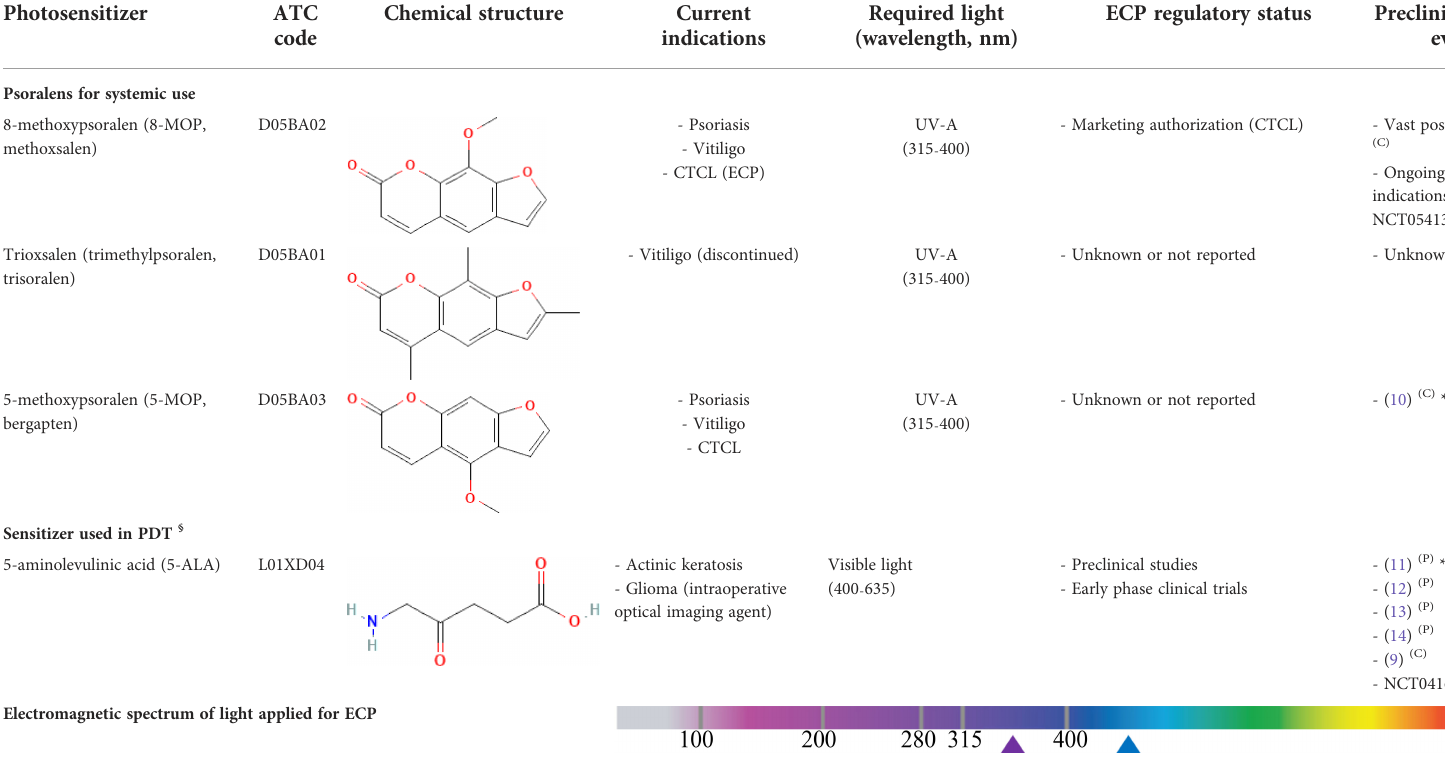
TABLE 1 Current and potential photosensitizer drugs for